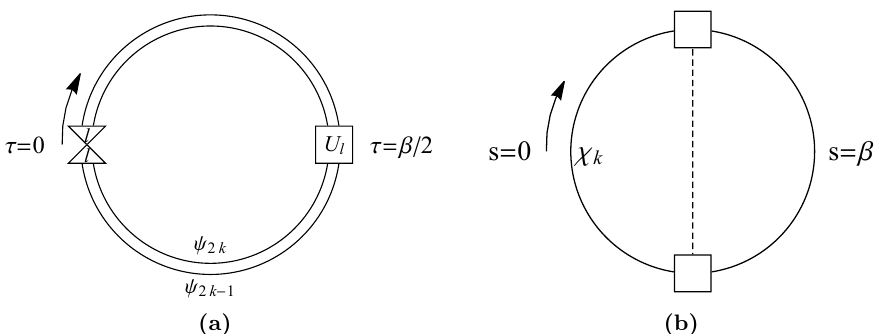
Figure 13. (a) Imaginary time contour for the twisted correlation function. In the left side ( τ = 0 , β ), a projective measurement | L l ih L l | with outcome l (denoted by the two triangles) is performed, and in the right side ( τ = β ), an associated decoding operator U l is applied. (b) 2 Imaginary time contour for the Majorana field χ k . The boundary condition from the decoding operator becomes a rotation between s = β and s = 3 β , indicated by the dashed 2 2